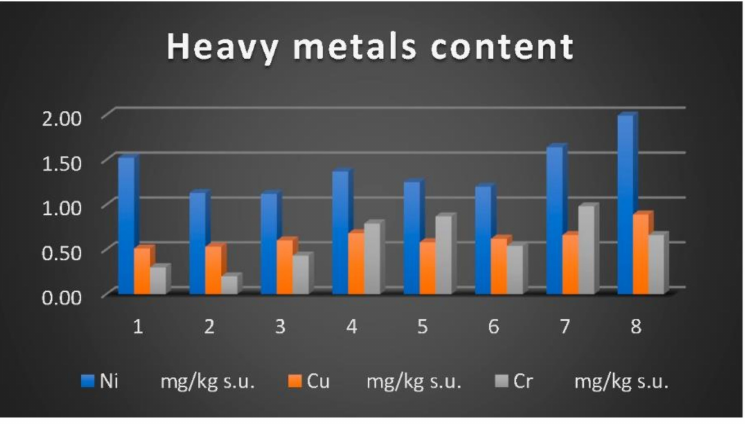
Figure 3. Heavy metals content in the sewage sludge (quarterly average